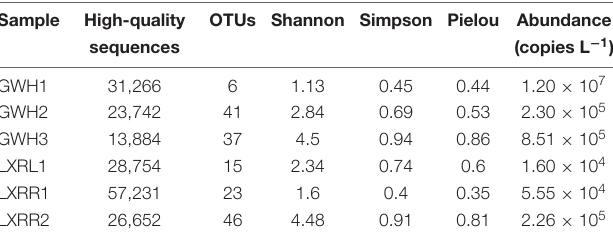
TABLE 2 | Diversity characteristics and abundance of anammox bacterial 16S rRNA gene. Sample High-quality OTUs Shannon Simpson Pielou Abundance